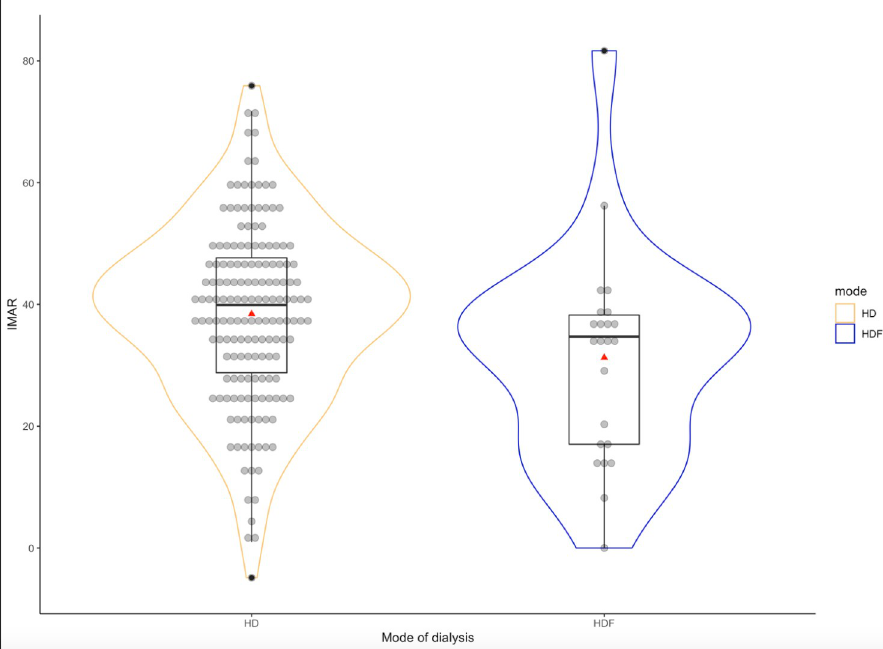
Fig 2. Ischaemia modified albumin ratio (IMAR) in patients treated by high-flux haemodialysis (HD) and haemodiafiltration (HDF). Red triangular symbols represent mean for treatment group (P = 0.035) and the horizontal black line represents the median for treatment group (P =